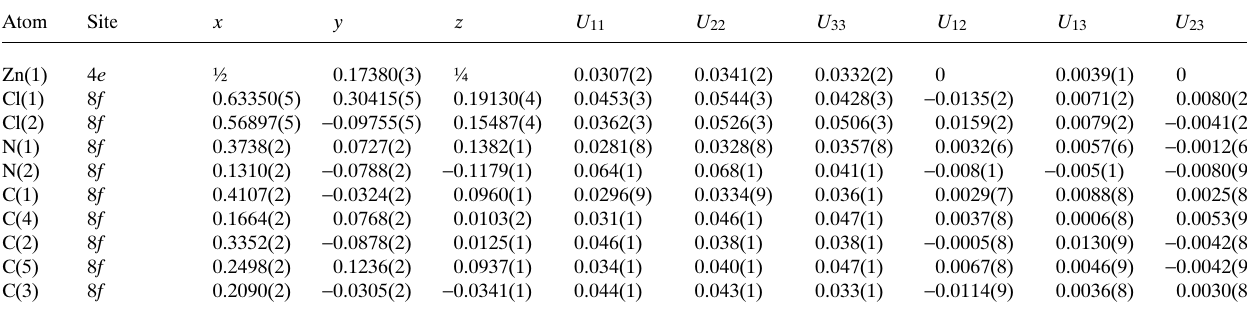
Table 3. Atomic coordinates and displacement parameters (in Å 2 )